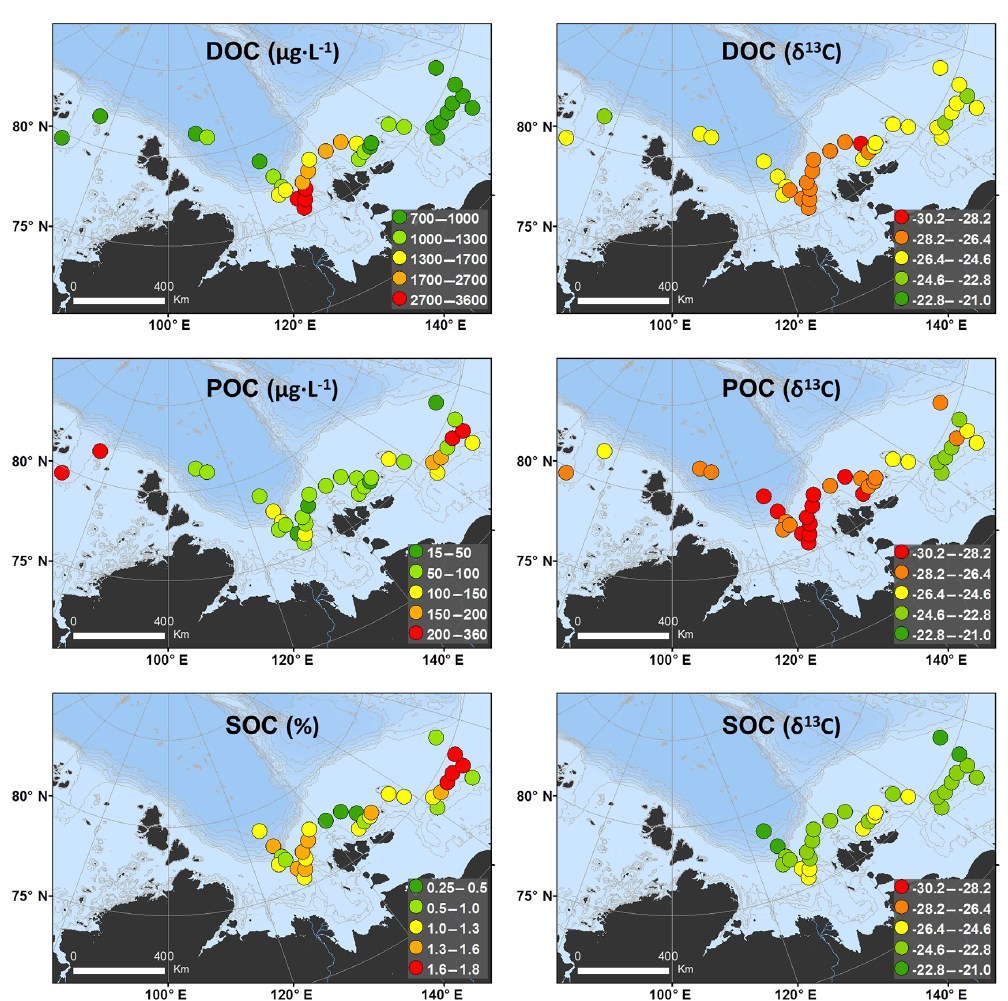
Figure 3. Spatial distribution of organic carbon concentrations and δ 13 C signatures in the DOC, POC (surface water samples at 8m depth) and SOC pools of the